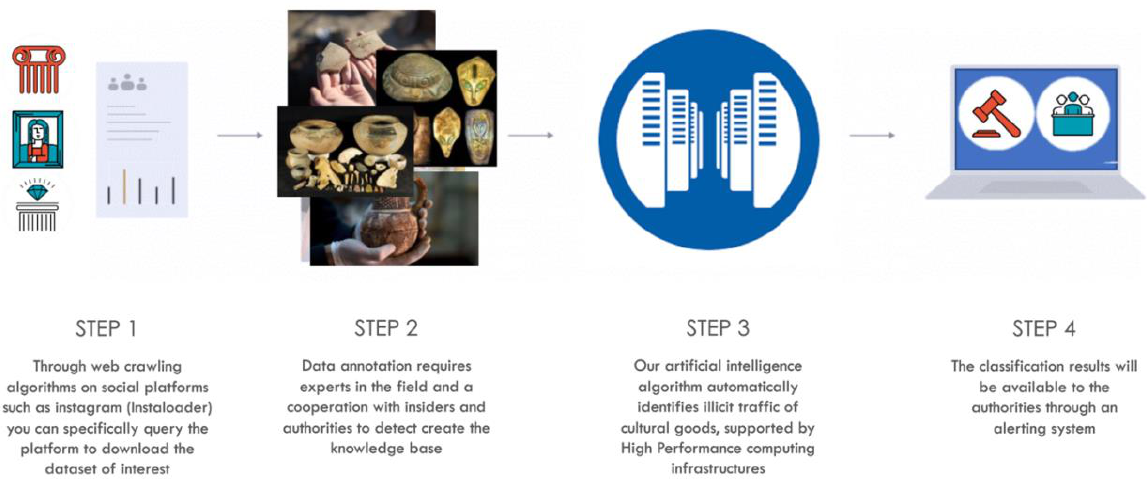
Figure 1. SIGNIFICANCE